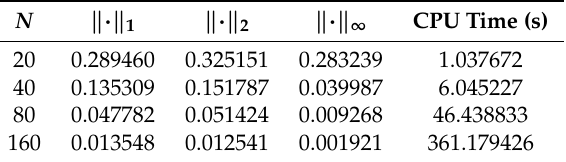
Table 2. Error table using finite difference-WENO scheme for the approximate solution p ( v , t ) graphically represented in Figure 1, at a final time t = 1.5 with the finest grid being N ∗ = 320.